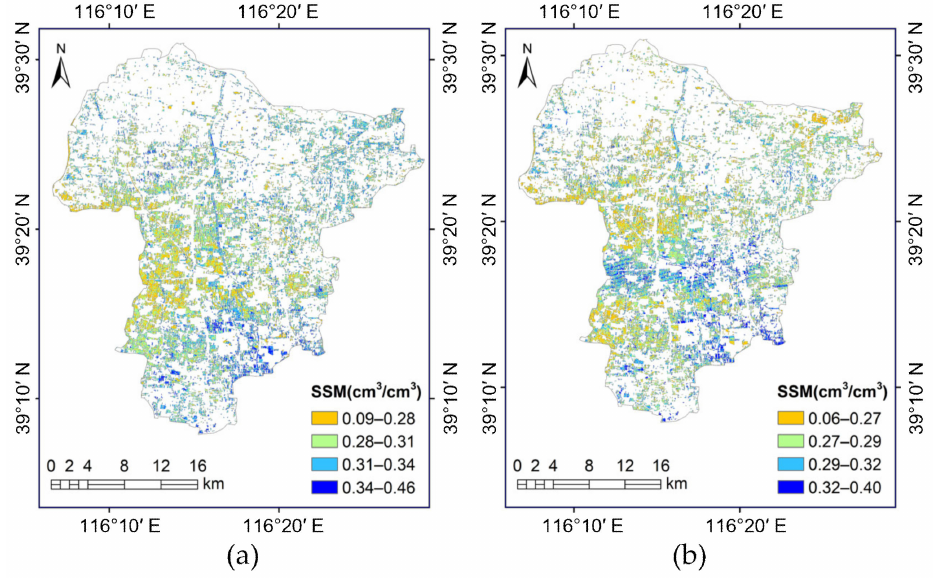
Figure 8. SSM mapping on two different dates: 28 April 2019 ( a ), and 29 April 2021 ( b ), in Gu’an, Hebei,